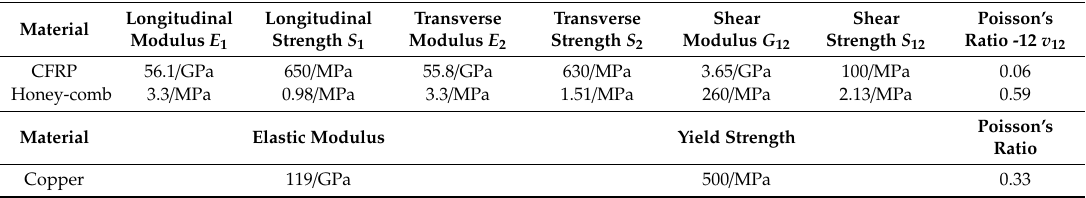
Table 2. Electrical and thermal properties of applied material at 25 ◦